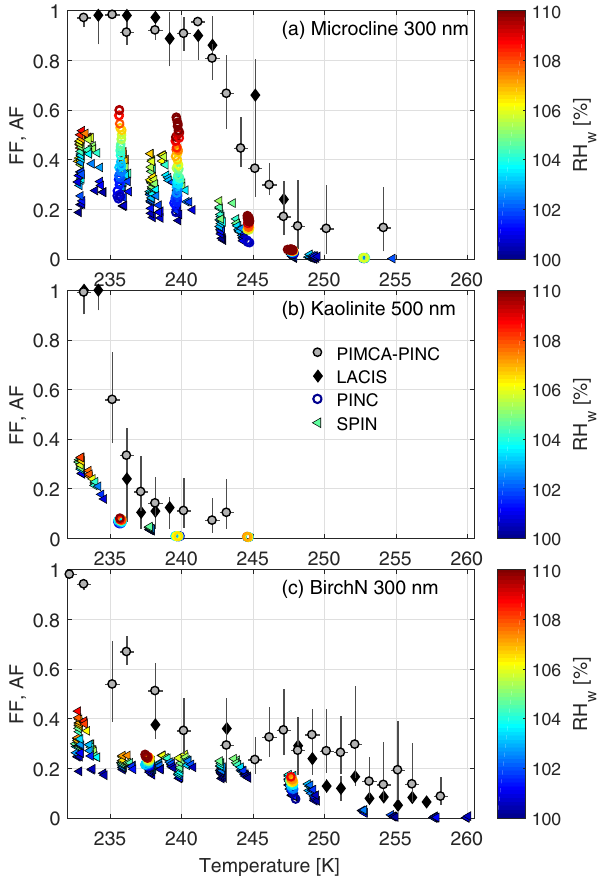
Figure 9. Comparison of all instruments. PIMCA-PINC and LACIS experiments were performed with droplet activation prior to expo- sure to freezing conditions. Results from immersion freezing exper- iments are reported as the FF. PINC and SPIN measured the acti- vated fraction (AF) at ice nucleation conditions above water satura- tion and RH w up to droplet breakthrough, which is the limitation for the scan range. RH w is indicated by the color bar. The uncertainty in the AF for PINC and SPIN is